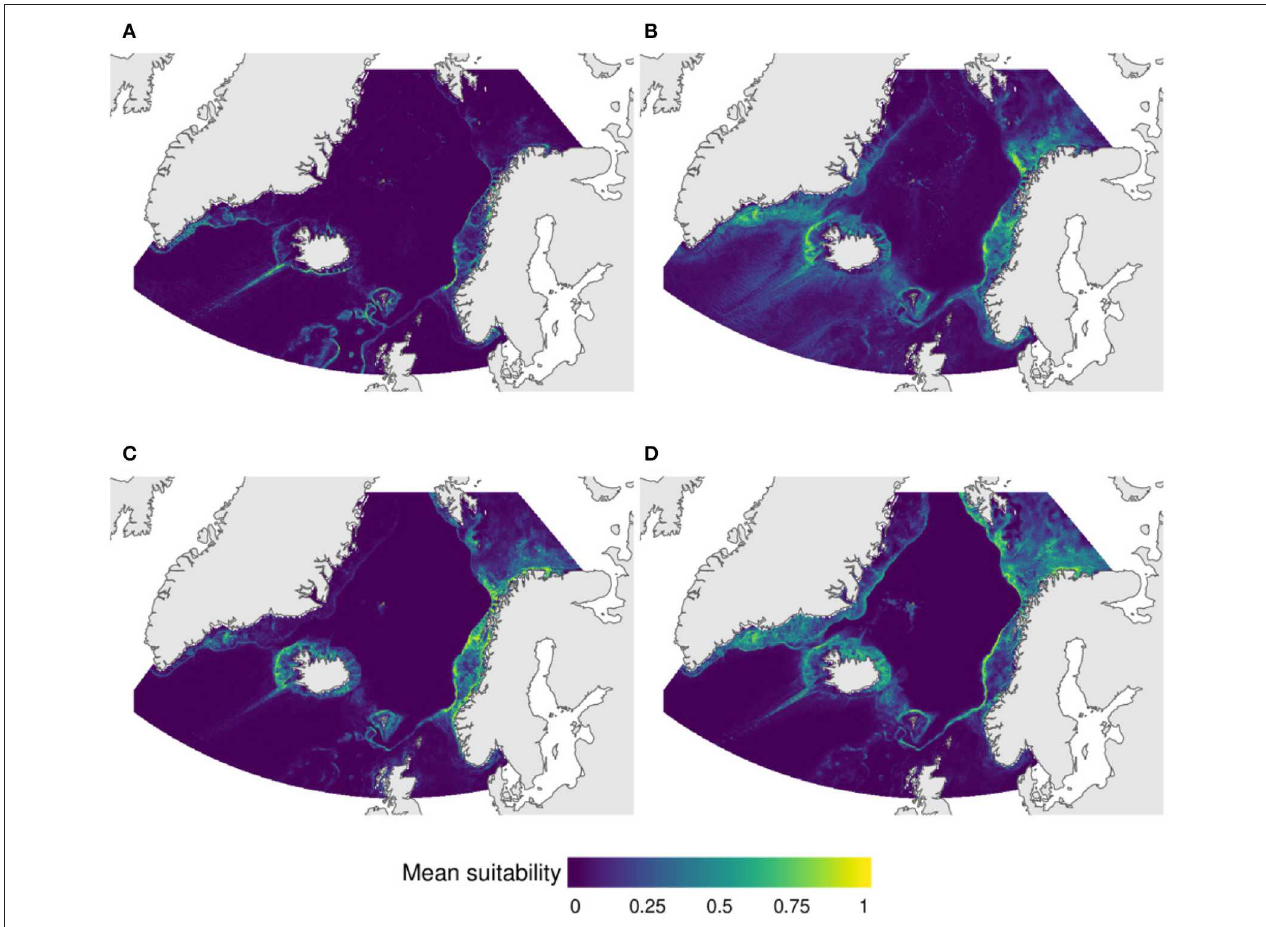
FIGURE 4 | Predicted distribution of VMEs based on stacked species distribution model (SSMD) of (A) the reef-forming corals Lophelia pertusa and Madrepora oculata , the gorgonians Paragorgia arborea , Primnoa resedaeformis , and Paramuricea sp., and Stylasterid corals, (B) ssponges of the taxa Geodia atlantica , G. macandrewi , G. phlegraei , Stryphnus sp., and Stelletta sp., (C) sponges of the taxa Mycale sp., Axinellidae, Phakellia , and Antho (Antho) dichotoma , and (D) sponges of the taxa Thethya sp., Geodia baretti , Polymastia sp., and Tetillidae